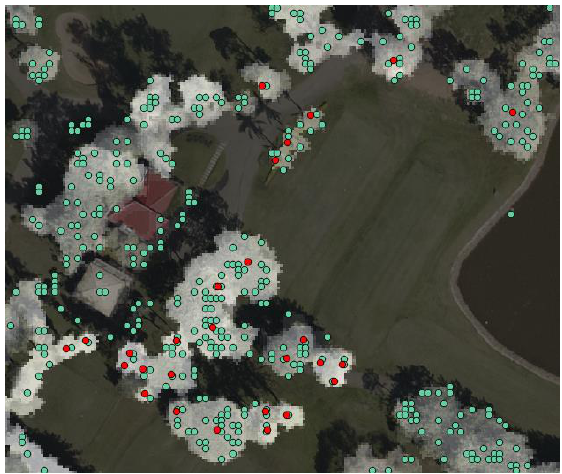
Figure 4. Extraction result of the VWF method using simple subtraction CHMs.